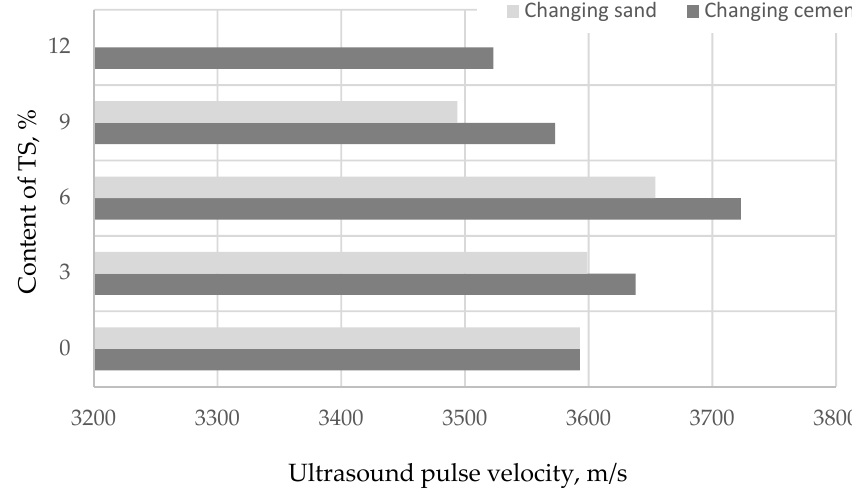
Figure 5. The impact of TS content on ultrasound pulse velocity (UPV).